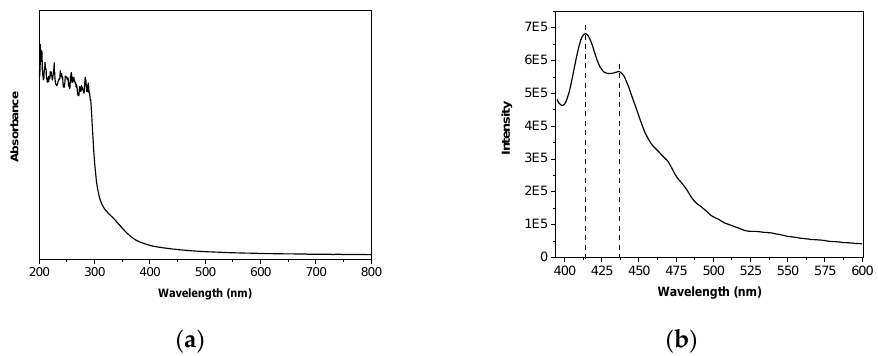
Figure 4. ( a ) UV-vis spectra and ( b ) fluorescence emission spectra (excitation at 370 nm) of SPI films.